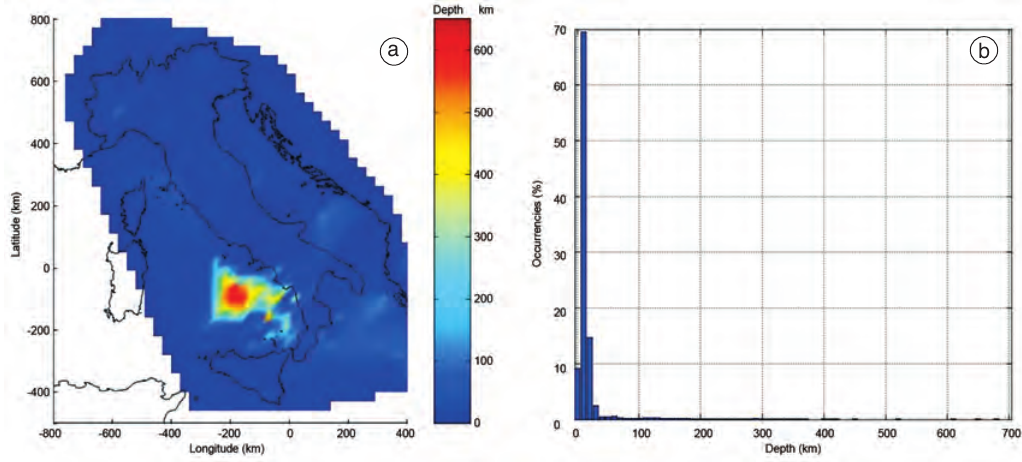
Fig. 12a,b. a) Hypocentral depths map distribution. The events selected have an error on the coordinates (Lat error ∗ Long error ∗ depth error) below 1000 km 3 . The interpolation is made on a grid of 30 km per side. b) Hy- pocentral depths distribution in class of 10 km each. The events selected have an error on the coordinates (Lat error ∗ Long error ∗ depth error) below 1000 km 3